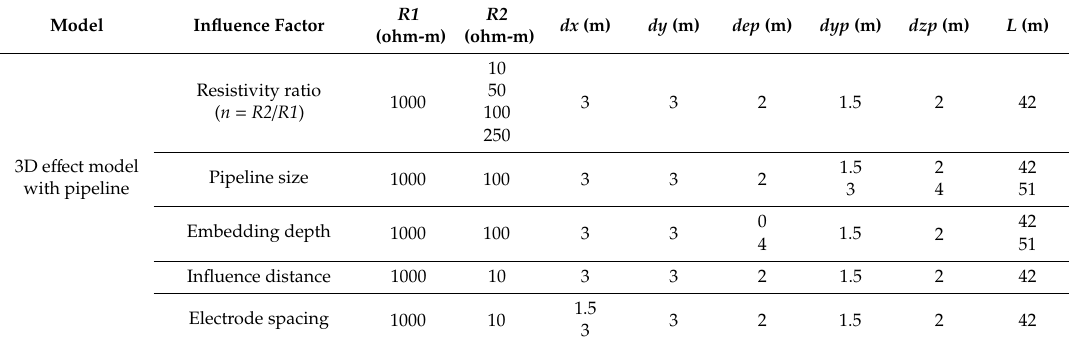
Figure 2. 3D e ff ect model with the pipeline formation. Figure 2. 3D effect model with the pipeline formation. Table 1. The explanatory table of the 3D e ff ect model parameters with the Table 1. The explanatory table of the 3D effect model parameters with the pipelines.